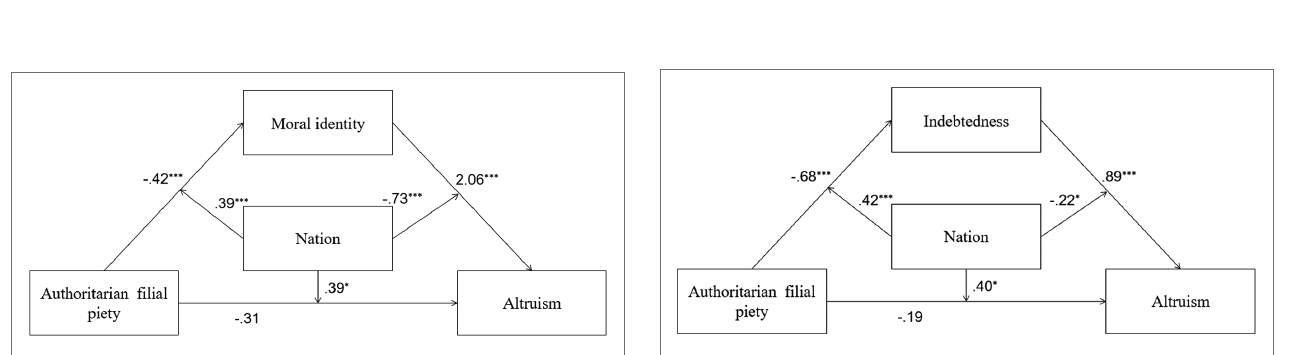
FIGURE 5 | Moderated mediation model showing standardized coefficients (Model 5); *** p < 0.001.